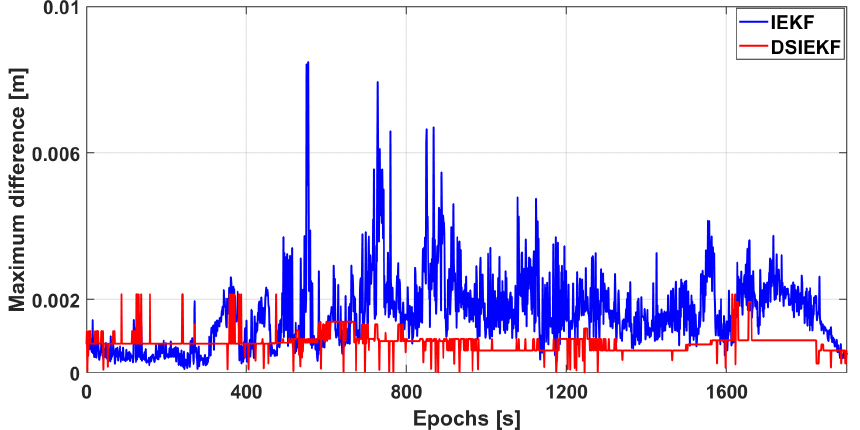
Figure 14. The maximum difference between the estimated distance parameters of the planes by means of the algorithms and the available information from the 3D city